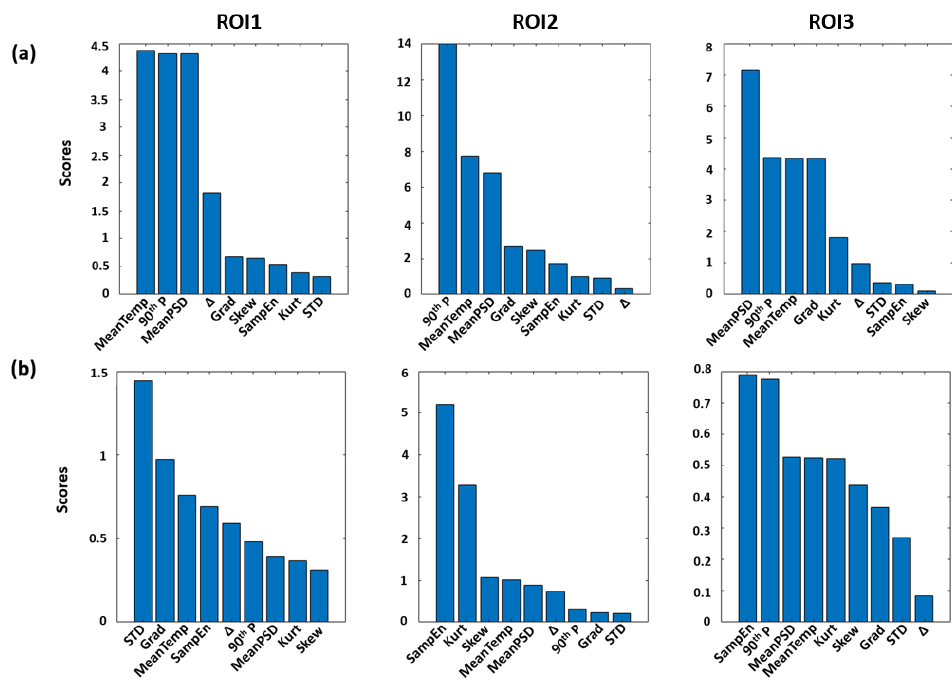
Figure 3. F-tests scores associated to each thermal feature computed for each ROI evaluated for the ARV ( a ) and MDF ( b ) estimation. ARV ( a ) and MDF ( b ) estimation.